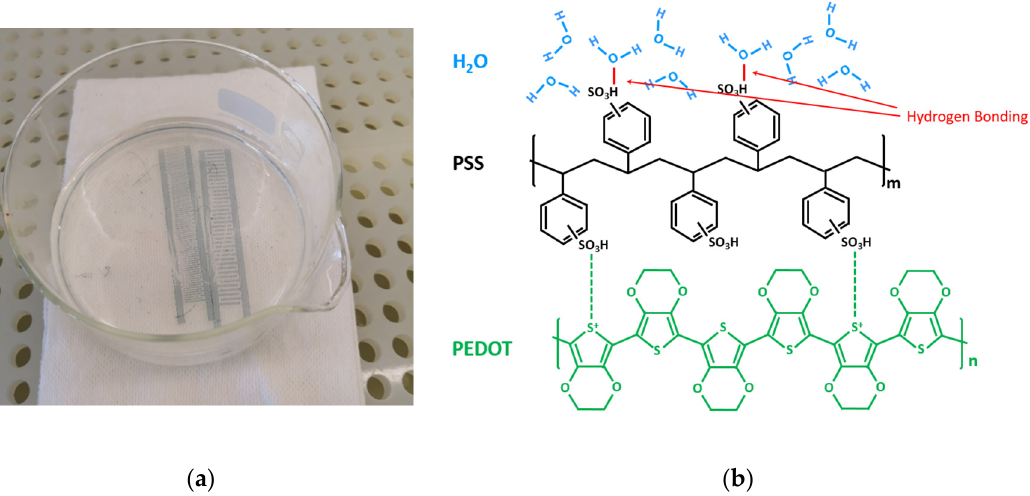
Figure 4. ( a ) Hydrogen bonding test; ( b ) the schematic of hydrogen bonding between PEDOT:PSS and deionized (DI) water.